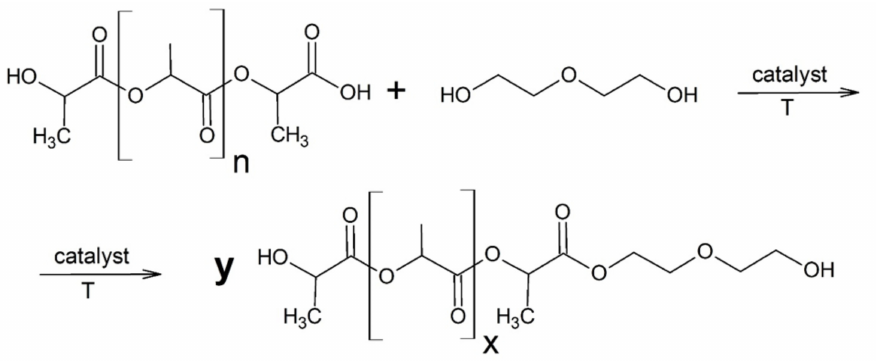
Figure 2. Glycolysis reaction of polylactide